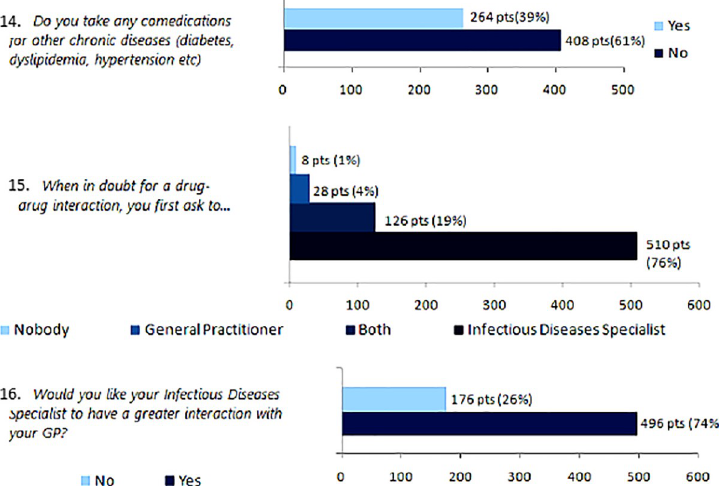
Fig 2. Management of co-medications and drug-drug interactions. Last three items of the survey investigated about the presence and the management of comedications.